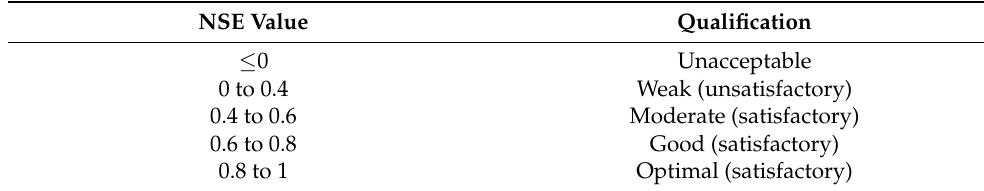
Table 1. Classification of the Nash–Sutcliffe efficiency (NSE)